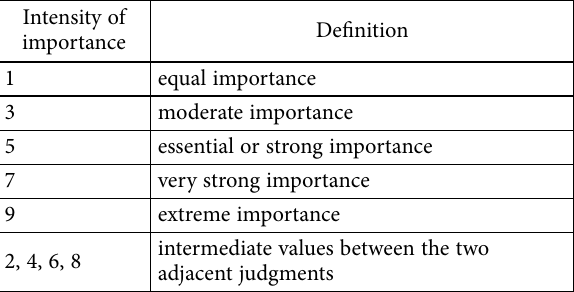
Figure 1. Structure for analysing the importance of similar units Table 1. Pair-wise comparison scale (Saaty 2008) Intensity of